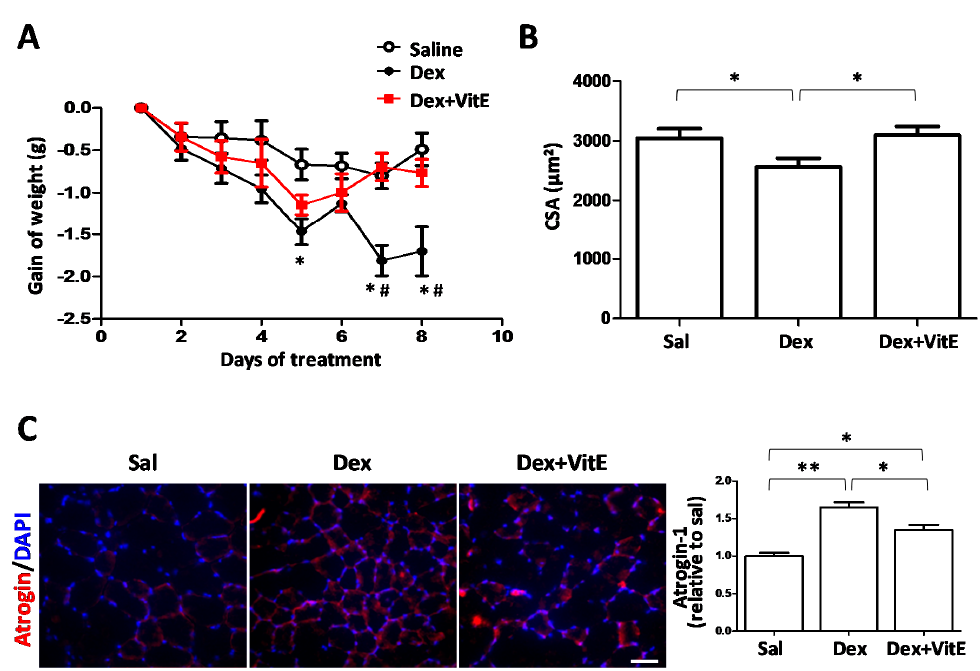
Figure 1. E ff ect of long term treatment with dexamethasone and vitamin E on weight loss and muscle atrophy in mice. Mice were daily treated for 7 days with saline (Sal) or dexamethasone (Dex; 10 mg / kg / day) and fed with vitamin E (VitE) supplemented diet (Dex + VitE). ( A ) The mice weight was recorded daily. The graph shows the loss of weight relative to the start of treatment. (Sal; n = 10; n Dex = 10; n Dex + VitE = 10). Significance was assessed by two-way ANOVA followed by Bonferroni post hoc test. * p < 0.05 Saline vs Dex; # p < 0.05 Dex vs Dex + VitE. ( B ) The cross-sectional area (CSA) of myofibers of tibialis anterior (TA) muscles was measured by o ff -line analysis of hematoxylin-eosin images. Five images of each muscle section were evaluated (Sal; n = 3; Dex; n = 3; Dex + VitE; n = 3). The results are expressed as mean ± SEM. ( C ) The presence and cellular distribution of the protein-degradation marker Atrogin-1 was evaluated by immunofluorescence assay in cross sections of TA muscles. The graph shows the red fluorescence intensity measured using Image J software. The results are expressed as mean ± SEM.* p < 0.05; ** p < 0.01; comparing as indicated with brackets (n Saline: 5; n Dex: 5; n Dex + VitE: 3). Scale bar: 50 µ